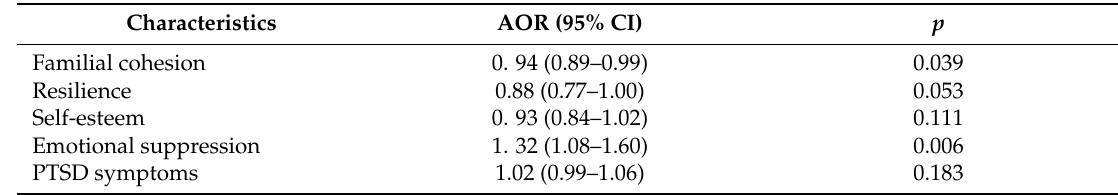
Table 3. Variables associated with suicidal ideation in North Korean refugee